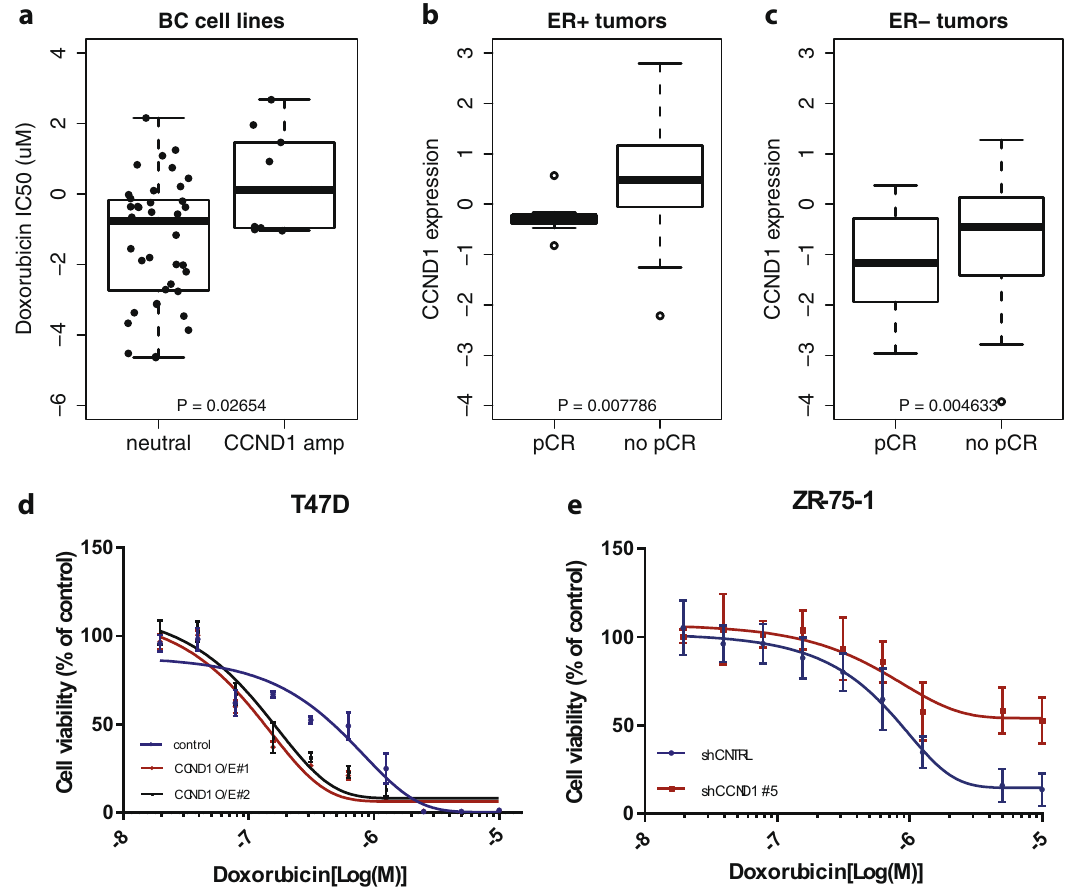
Fig. 4 Exploration of the effect of CCND1 ampli fi cation on chemotherapy sensitivity. a Boxplots showing sensitivity to doxorubicin in CCND1 neutral (left) and ampli fi ed (right) breast cancer cell lines in the GDSC1000 database. b Boxplots showing the association between CCND1 gene expression levels and response to neoadjuvant doxorubicin + cyclophosphamide in ER + tumors from our neoadjuvant cohort. pCR pathological complete response. c Boxplots showing the association between CCND1 gene expression levels and response to neoadjuvant doxorubicin + cyclophosphamide in triple negative tumors from our neoadjuvant cohort. pCR pathological complete response. d Effect of CCND1 overexpression on doxorubicin sensitivity in T47D ( CCND1 neutral) breast cancer cell lines. Blue: control, red and black: CCND1 overexpression. Mean ± SD values of two independent CCND1 overexpressing cell lines (O/E #1, O/E #2),with technical replicates are depicted ( n = 3). e Effect of CCND1 knock-down on doxorubicin sensitivity in ZR-75-1 ( CCND1 ampli fi ed) breast cancer cell lines. Blue: control, red: upon CCND1 knock-down. Mean ± SD values of independent biological replicates are shown ( n = 2). For box plots in this fi gure, the boxes indicate the interquartile range, while lower and upper bars correspond to the minimum and maximum non-outlier values of the data distribution. Outliers are de fi ned as values outside 1.5× the interquartile range from the box. The center line indicates the median